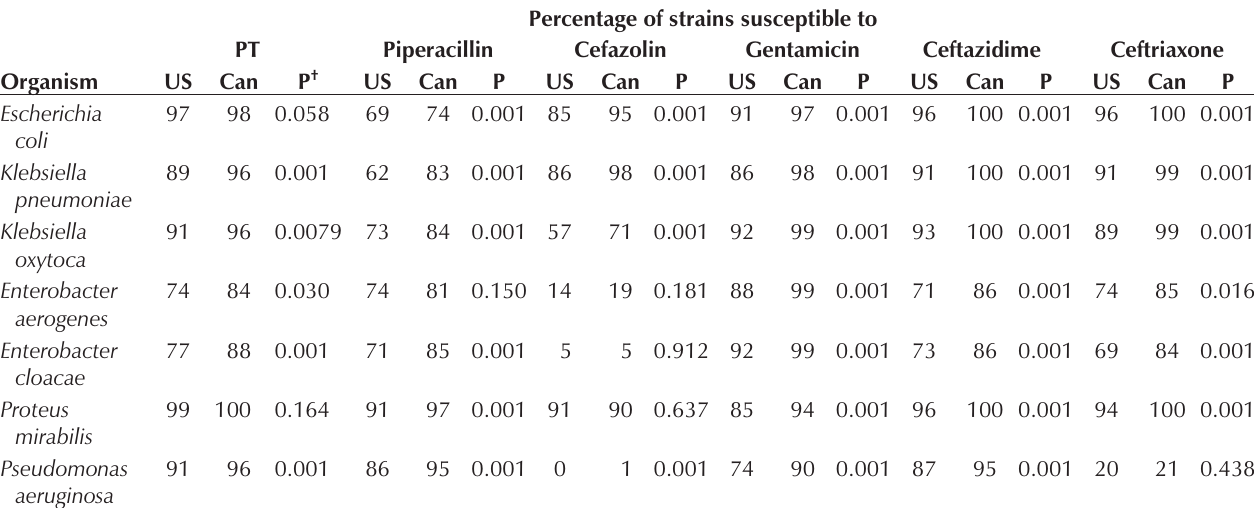
Comparative activity of aerobic Gram-negative bacilli in Canada (Can) and the United States